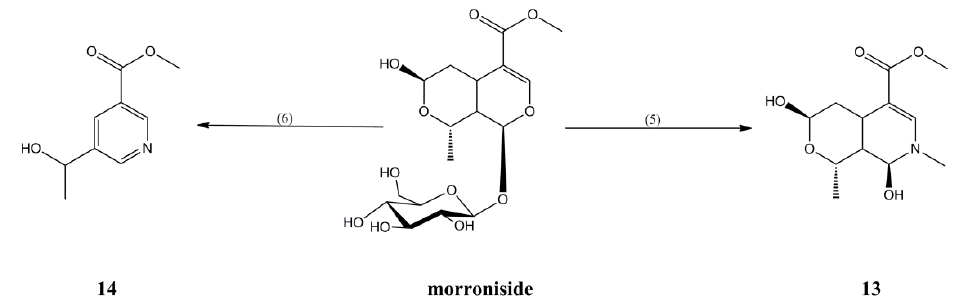
Figure 4. Synthesis of Compounds 13 and 14 . (5) Methylamine ethanol solution, 10 °C, 3 h. (6) C 2 H 5 OH, HOAc-NaAc buffer solution, β-glucosidase, 50 °C, 3 h.